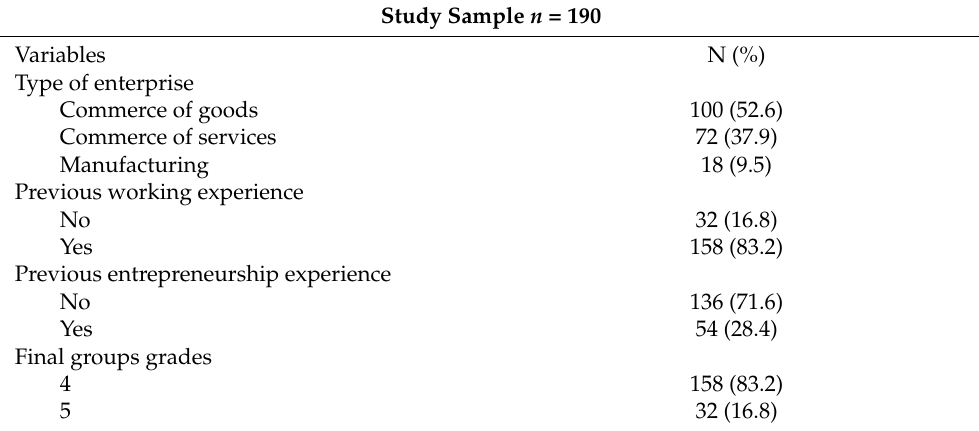
Table 2. Entrepreneurship variables